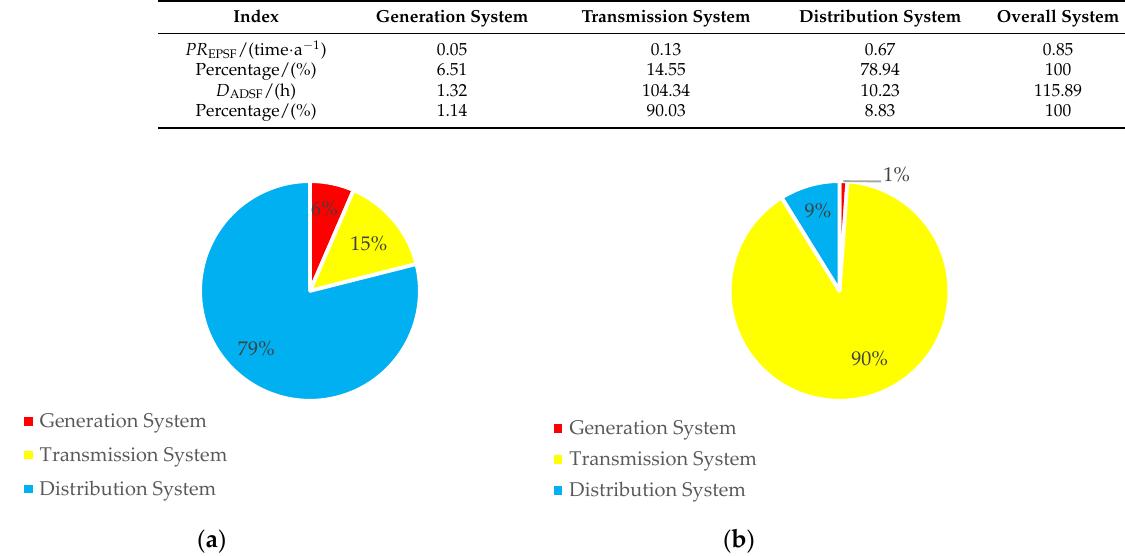
Figure 7. Percentage of subsystem indicators. ( a ) Percentage of P EPSF for subsystems; ( b ) percentage of P ADSF for subsystems.